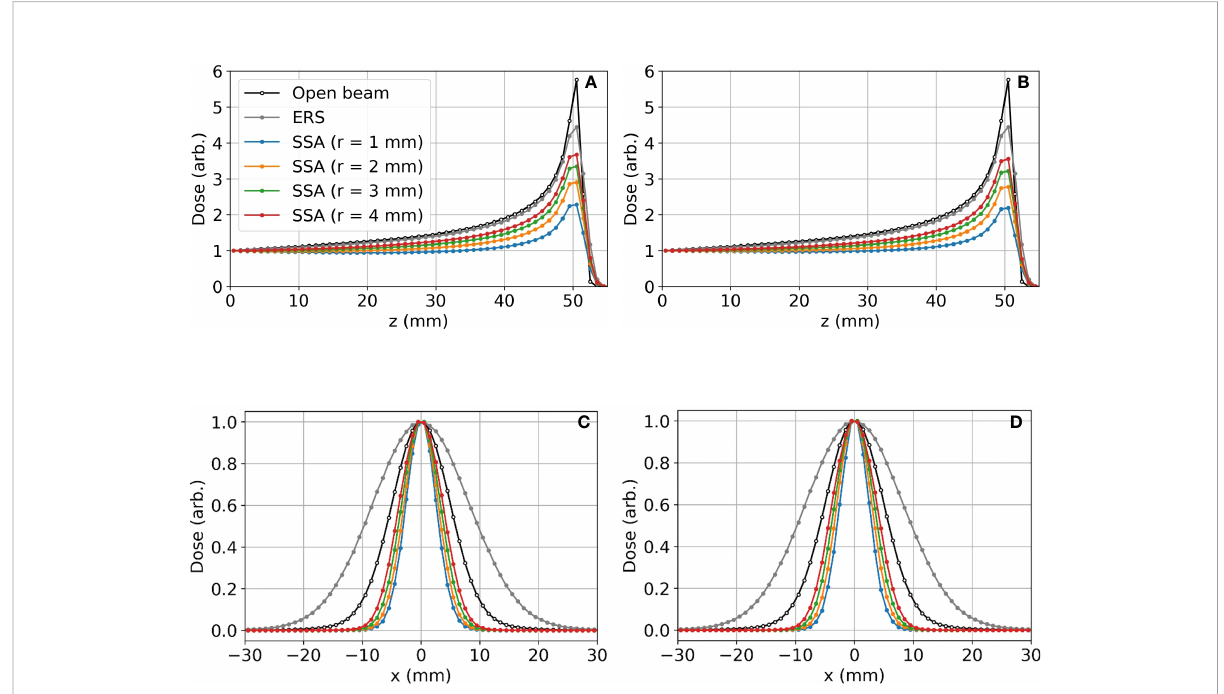
FIGURE 6 Lateral proton spot dose and IDD pro fi les for different SSA con fi gurations where the BP is about 50 mm deep in the water phantom: (A) IDD pro fi les for tungsten; (B) IDD pro fi les for nickel; (C) Transverse proton spot dose pro fi les at the BP depth for tungsten; (D) Transverse proton spot dose pro fi les at the BP depth for nickel. For these data, the ASD was 50 mm. The radius ( r ) of the SSA opening for both materials was varied from 1 mm to 4 mm indicated by different colors in the fi gure.